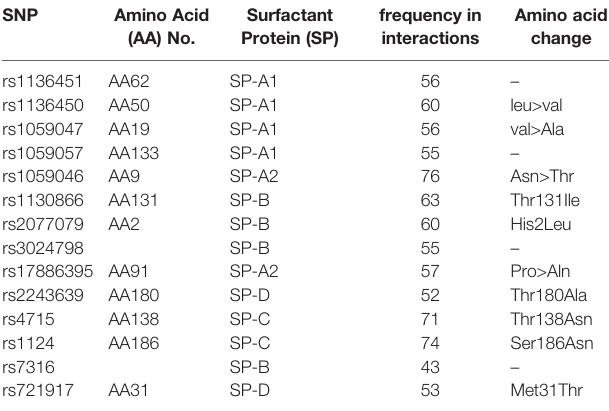
TABLE 4 | Frequency of SNPs in signi fi cant SNP-SNP interactions. SNP Amino Acid (AA) No.